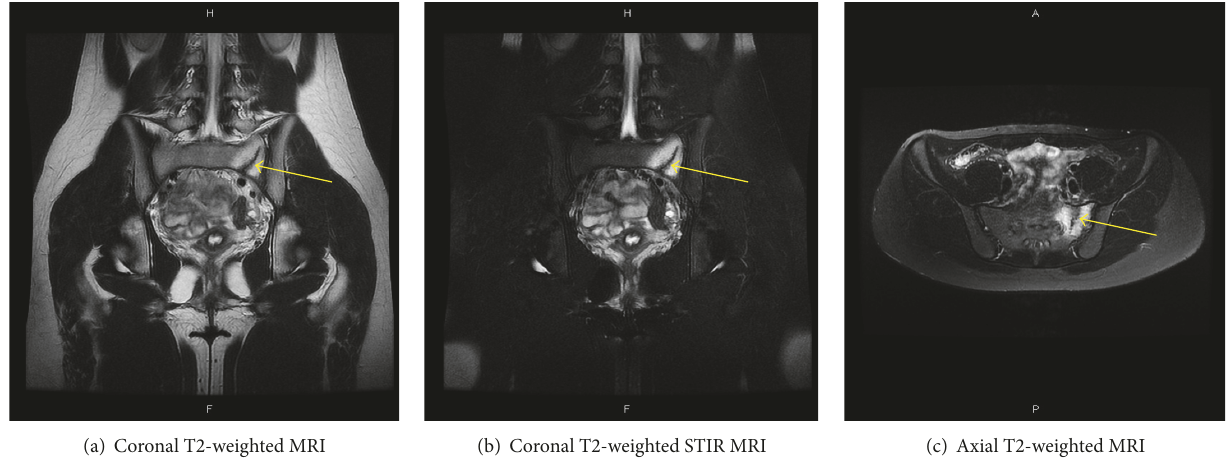
Figure 2: MRI T2 and T2 short tau inversion recovery (STIR) scan shows a linear area of decreased signal intensity of left sacrum with surrounding a T2 hyperintense area